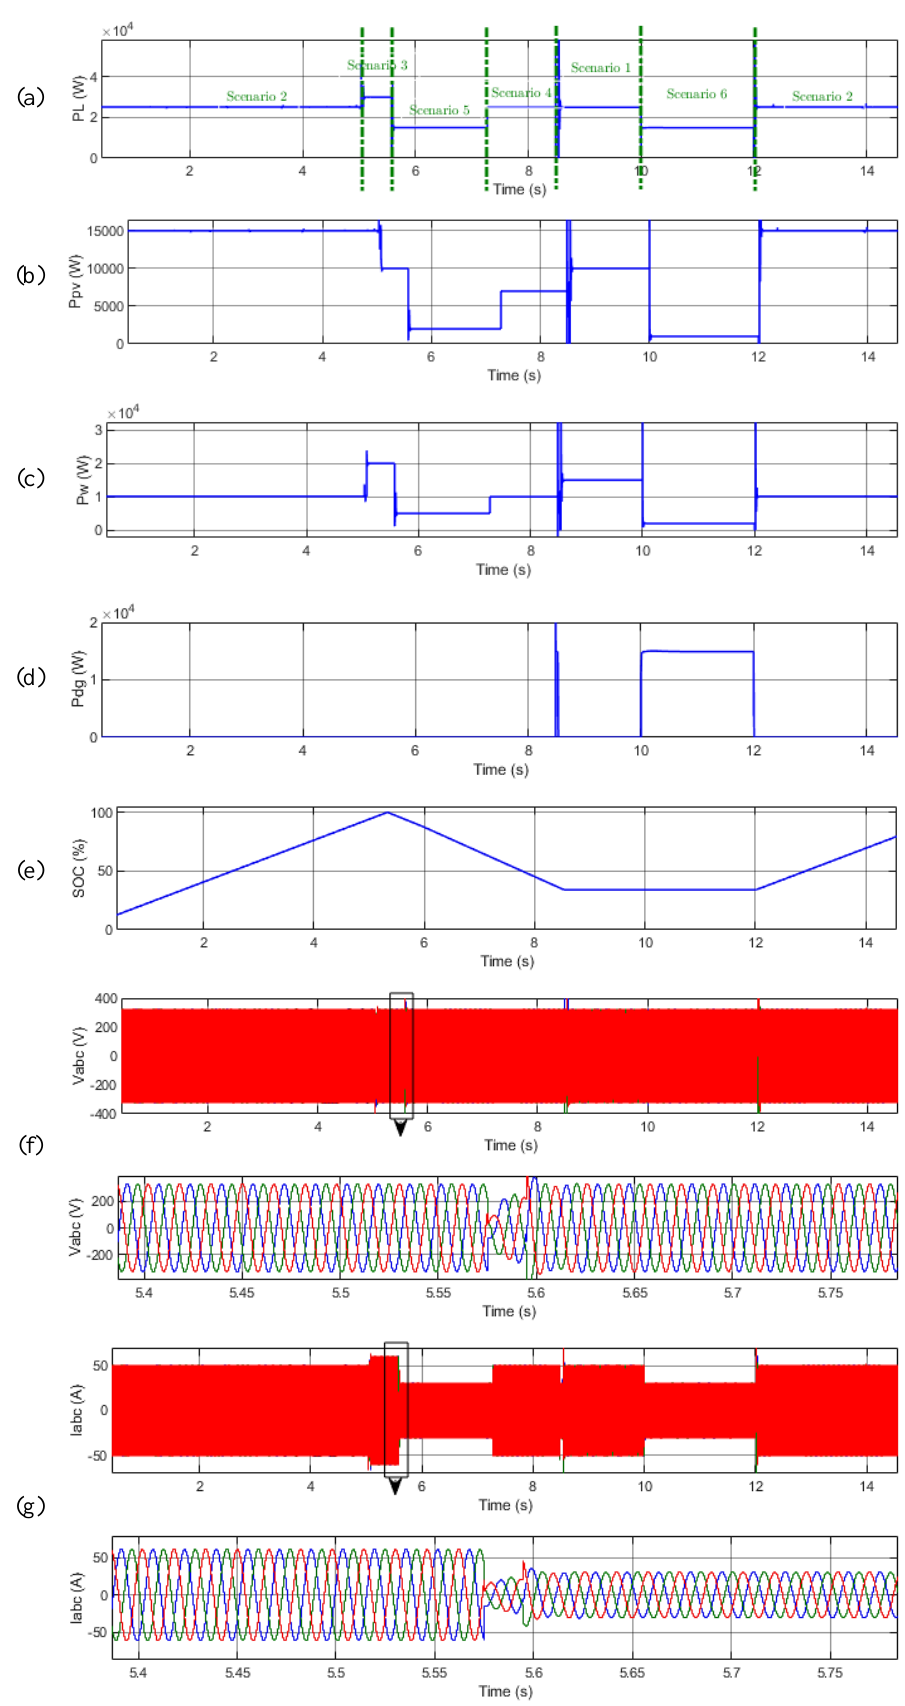
Figure 13. Simulation results of the IHPS. a) Load power (W); b) Power from PVS (W); c) Power from WECS (W); d) Power from DG (W); e) Batteries state of charge (%);f. Load Voltage (V); g) Load current